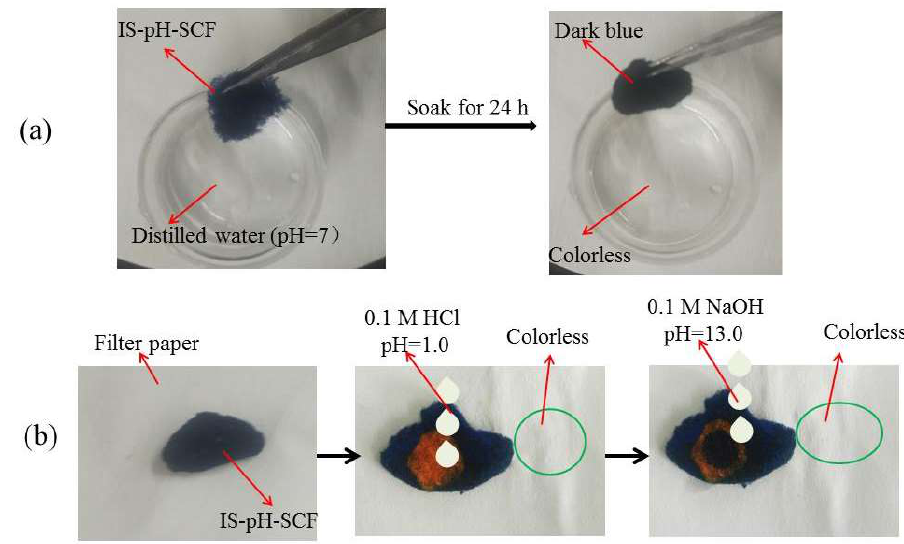
Figure 7. Release tests ( a ) in distilled water and ( b ).dropping acid or alkaline solutions.